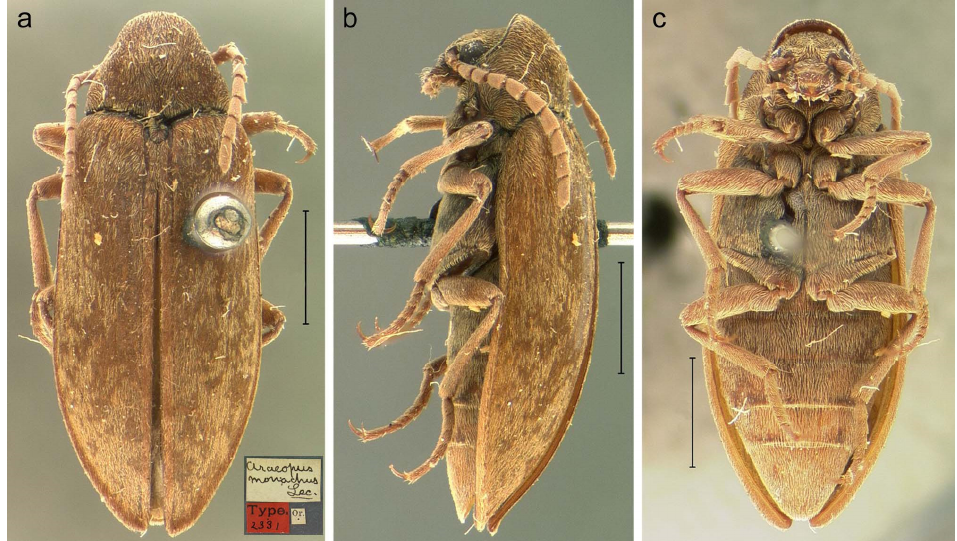
Figure 1. Araeopidius monachus (LeConte, 1874), syntype habitus. ( a ) Dorsal view (and original labels); ( b ) left lateral view; ( c ) ventral view. Photographs courtesy of Crystal Maier and Charles Farnum, Museum of Comparative Zoology, Harvard University, MA, USA. Scale bars = 2.0 mm.